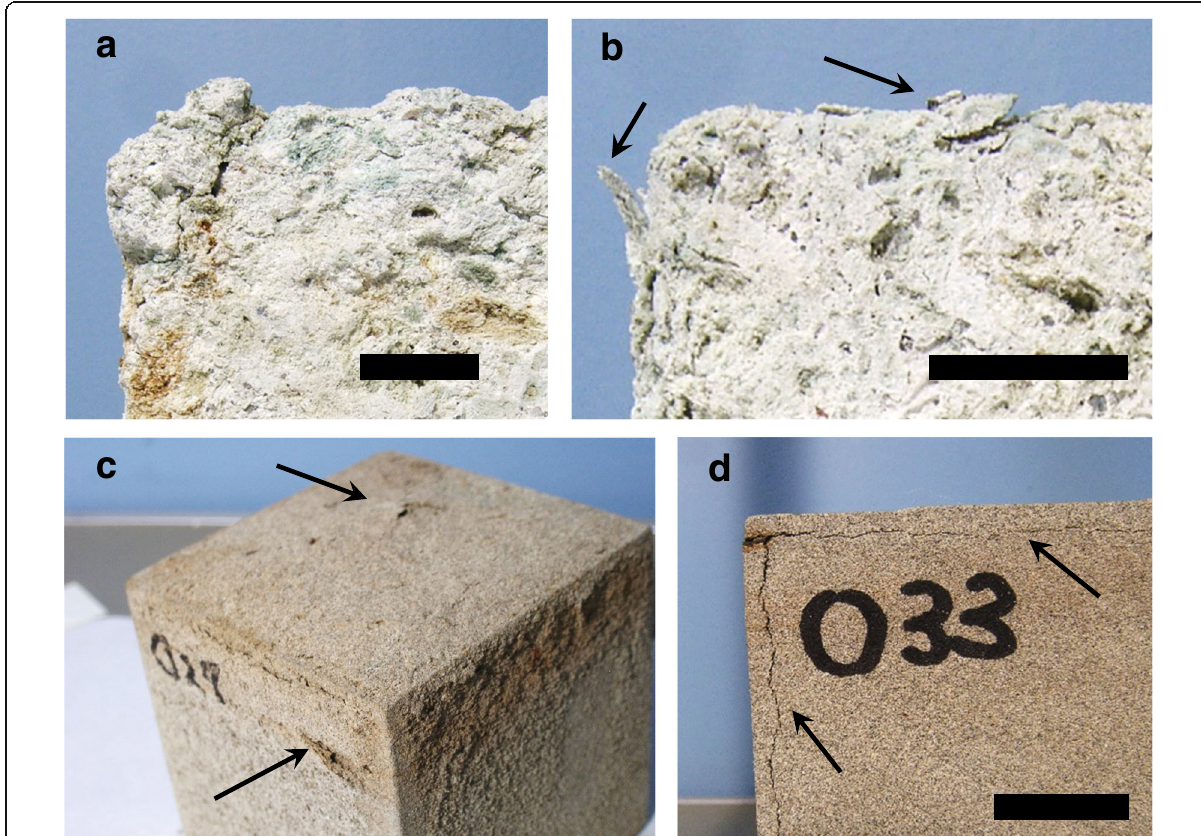
Fig. 6 Oya tuff and Aoshima sandstone with NaCl or MgSO 4 subjected to 200 humidity-change cycles. The scale bars are 1 cm long. Oya tuff with NaCl ( a ) and MgSO 4 ( b ) showed irregular morphology on their surface. Millimeter-scale fragments flaked from the surface of the Oya tuff with MgSO 4 . Aoshima sandstone with NaCl ( c ) showed swelling on the surface. Cracks parallel to the rock surface were observed on the edge of the Aoshima sandstone with